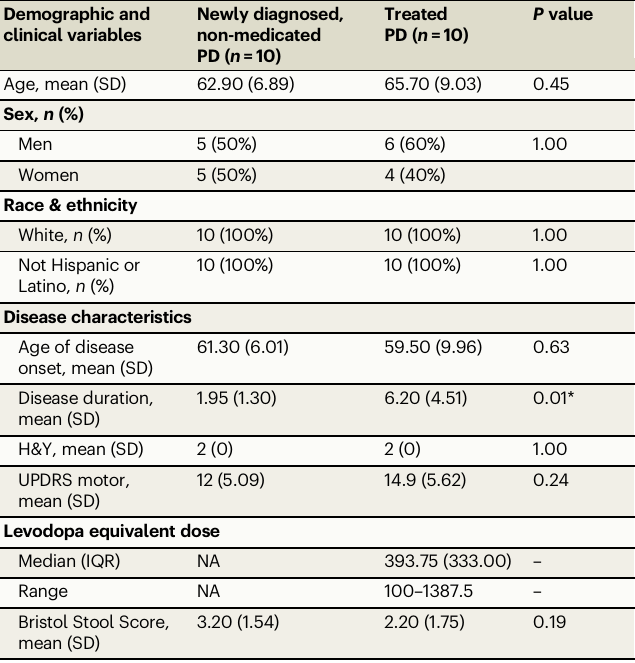
Table 4 | Parkinson ’ s disease participant